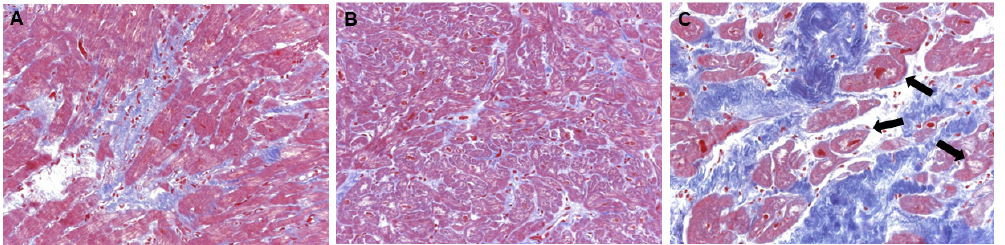
Figure 1. Histology in different stages of lymphocytic myocarditis and DCM. EMB samples of patients demonstrating ( A ) chronic myocarditis, ( B ) healed myocarditis and ( C ) DCM. Chronic myocarditis shows focal and/or diffuse fibrosis (blue tissue) but no myocyte necrosis. Healed myocarditis shows no myocyte necrosis and mild interstitial fibrosis. DCM is characterized by hypertrophic and/or atrophic myocytes with loss of myofibrils and vacuolar degeneration ( ) as well as severe focal and/or diffuse interstitial fibrosis.